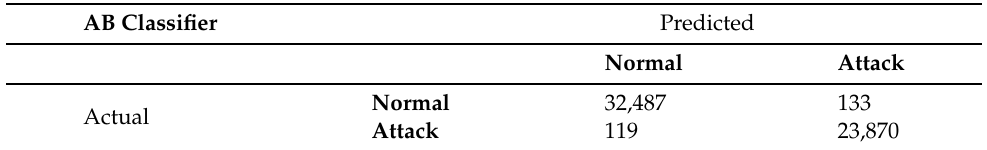
Table 6. Confusion Matrix of Adaboost (AB) Classifier Test for malicious and normal traffic detection over IoT healthcare dataset generated using IoT-Flock [16,24].